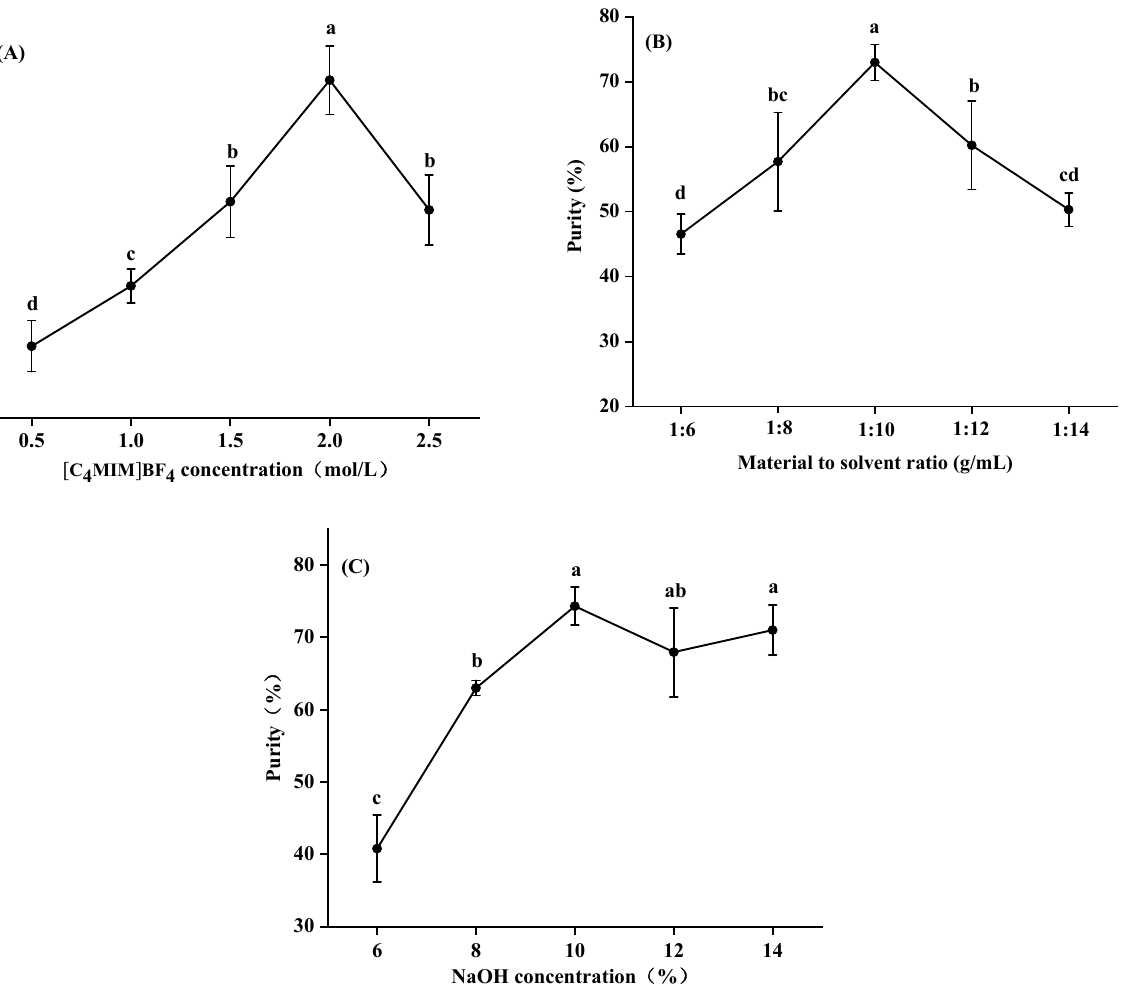
Figure 3. Effect of [C 4 MIM]BF 4 concentration ( A ), material to solvent ratio ( B ) and sodium hydroxide concentration ( C ) on the purity of saponins by ionic liquid purification. Values are means of triplicate ± standard deviation. Different lowercase letters represent significant differences ( p < 0.05).